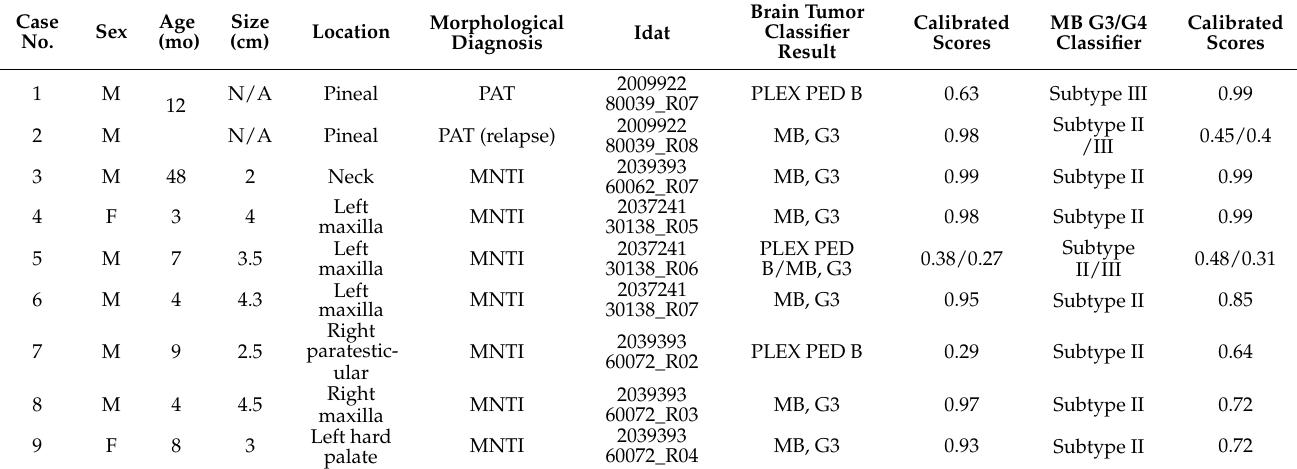
Table 1. Clinicopathological and molecular features of seven MNTIs and one